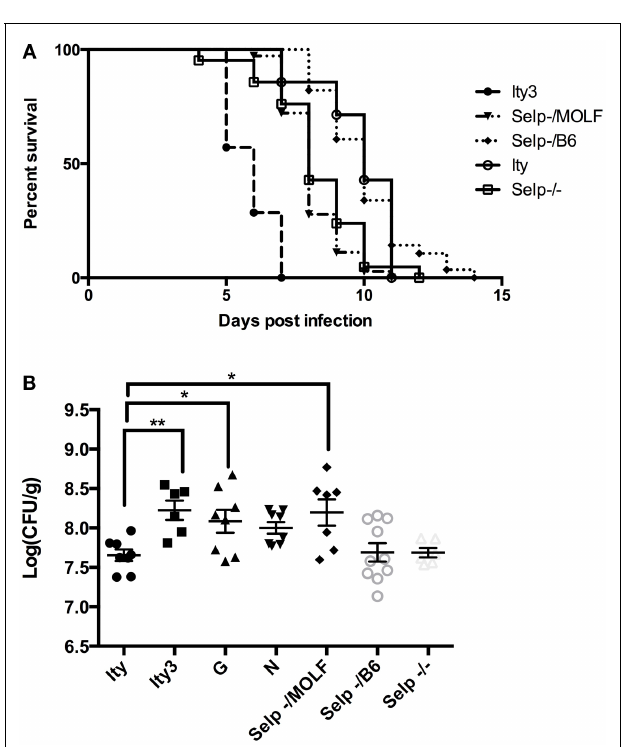
FIGURE 6 |Allelic complementation between Ity3 congenic mouse and Selp deficient mice . In order to assess the impact of the MOLF/Ei Selp locus, Selp − / − mice were crossed with Ity and Ity3 mice to generate mice carrying the knock-out allele complemented by the MOLF/Ei allele at Selp or C57BL/6J allele at the Ity3 locus. (A) Survival curves of the congenic Ity ( n = 7), Ity3 ( n = 7), knock-out Selp − / − ( n = 21), and Selp − /MOLF ( n = 36), Selp − /B6 ( n = 56) mice after infection with Salmonella typhimurium .The Selp − / − and Selp − /MOLF show a similar curve after infection with Salmonella typhimurium , both of which are more susceptible than the control Ity congenic mice and Selp − /B6 , but more resistant than the mice carrying the entire Ity3 locus ( Ity3 ). (B) Bacterial burden in the spleen of congenic Ity ( n = 8) and Ity3 ( n = 6), sub-congenic Ity3.RecG ( n = 8), and Ity3.RecN ( n = 8) and Selp − / − ( n = 6) and compound heterozygous ( n = 7 for Selp − /MOLF and n = 10 for Selp − / B6 mice after